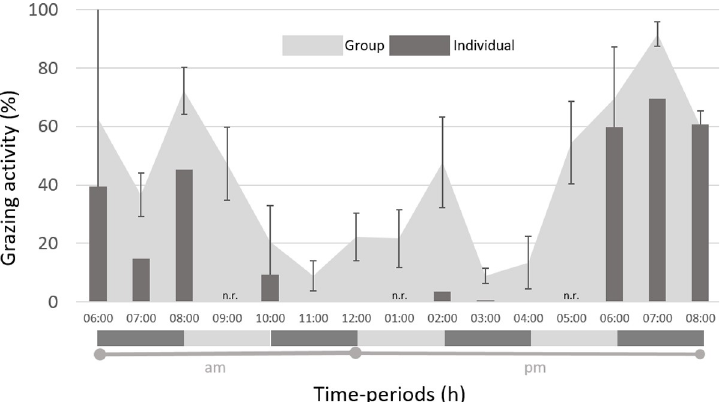
Fig 4. Comparison of daily grazing pattern obtained with POV cameras (individual) or by direct observation (group). Group grazing refers to the proportion of animals grazing in the flock (mean ± standard error of mean [SEM]; n = 15). Individual grazing refers to the proportion of minutes per hour (mean ± SEM; n = 3). n.r. = not recorded.